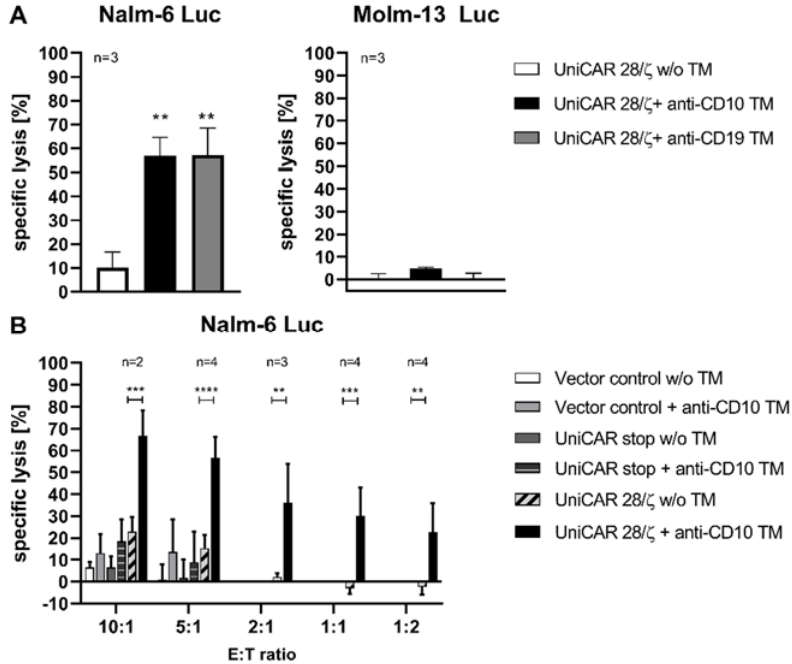
Figure 3. Targeting Nalm ‐ 6 Luc cells with UniCAR T ‐ cells armed with anti ‐ CD10 TM. ( A ) Either Nalm ‐ 6 Luc or Molm ‐ 13 Luc cells were incubated with UniCAR T ‐ cells in the addition of 50 nM anti ‐ CD10 or anti ‐ CD19 TM at 5:1 effector to target cell (E:T) ratio (** p < 0.0021, comparison to sample w/o TM; One ‐ way ANOVA with Dunnett’s multiple comparison test). ( B ) Nalm ‐ 6 Luc cells were incubated with different ratios of UniCAR T ‐ cells for 7 h in the absence, or presence, of 50 nM of the anti ‐ CD10 TM. The Vector control (expressing EGFP only), or the UniCAR stop (lacking signaling domains) T ‐ cells were included as controls at the two highest E:T ratios. The cytotoxic effect was then evaluated using a luminescence ‐ based assay. Results are shown as mean ± SD for two to four independent T ‐ cell donors as indicated in the figure (** p < 0.0021, *** p < 0.0002, **** p < 0.0001, comparison to samples w/o TM; Two ‐ way ANOVA with Bonferroni’s multiple comparison test).